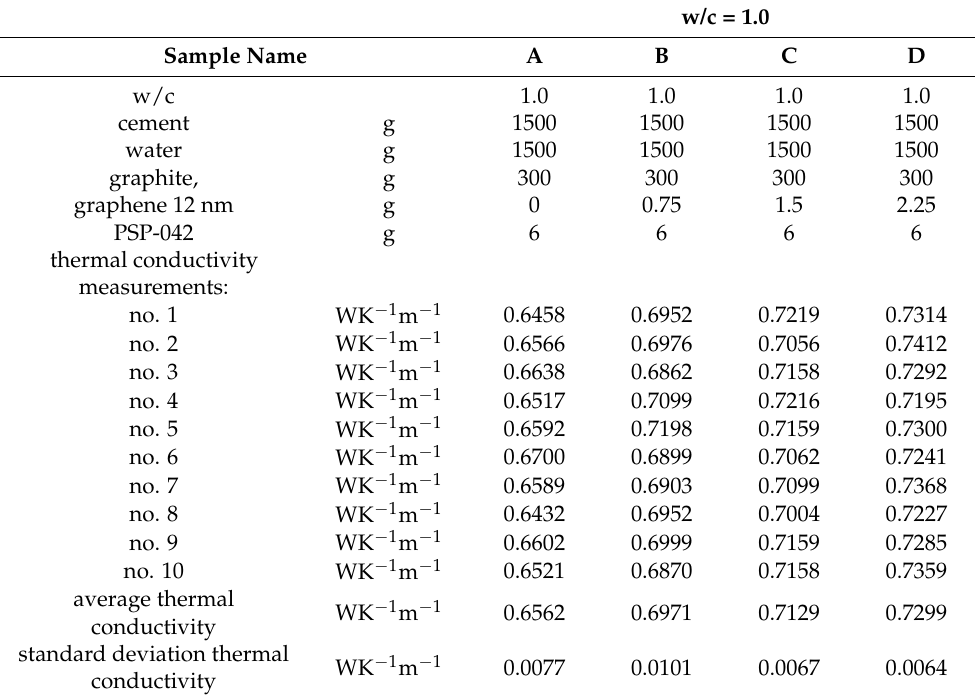
Table 6. Thermal conductivity test results of the hardened sealing slurries: all